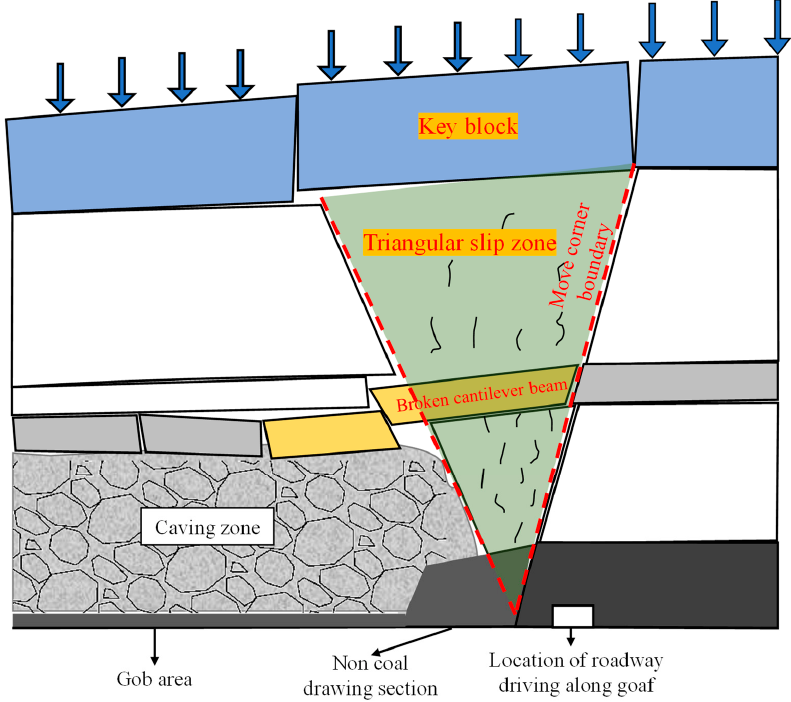
Figure 13. The vertical triangular slip zone structure model [51].